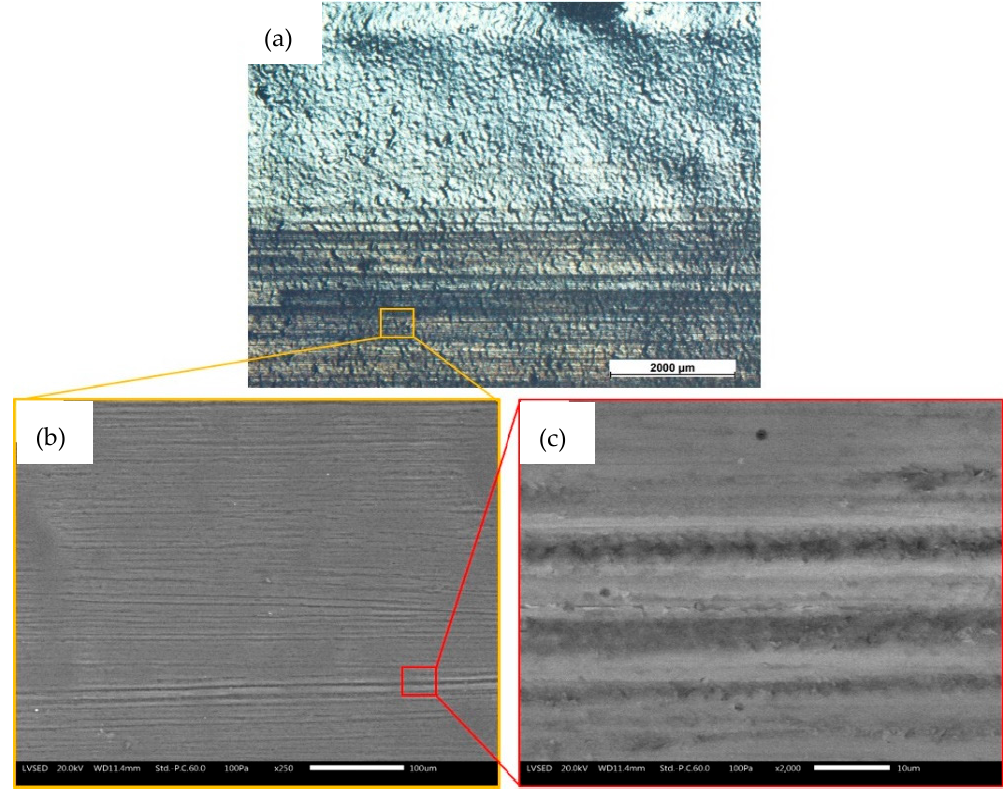
Figure 14. Optical stereomicroscope ( a ) and SEM ( b , c ) micrographs of sample g-0.1 surface morphology after the 1000 scrub test cycles.